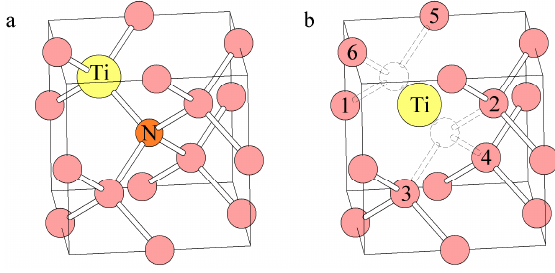
Figure 3. ( a ) Proposed model for the N3 center. ( b ) Proposed model for the OK1 center.